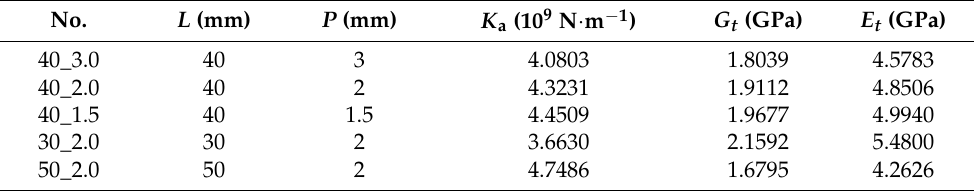
Table 5. Material parameters of the TLE with different types of threaded structures (source elaborated by authors).